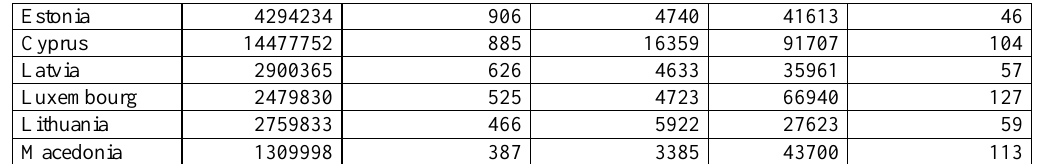
Table 3 : Tourism Indicators by Degree of Urbanisation (Average 2002-2012)